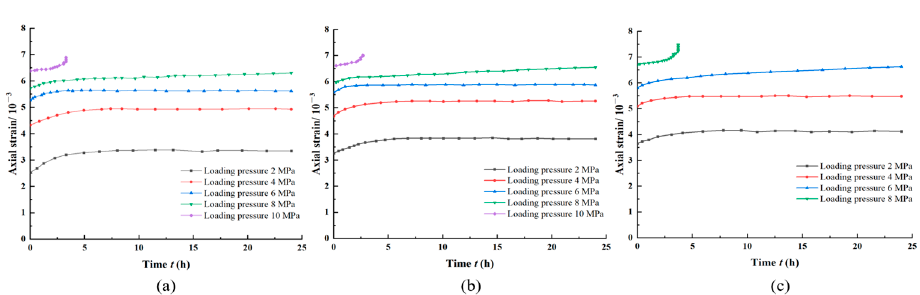
Figure 10. Creep deformation curves at different porosity levels. ( a ) The porosity interval is 5~10%; ( b ) the porosity interval is 10~15%; ( c ) the porosity interval is 15~20%.